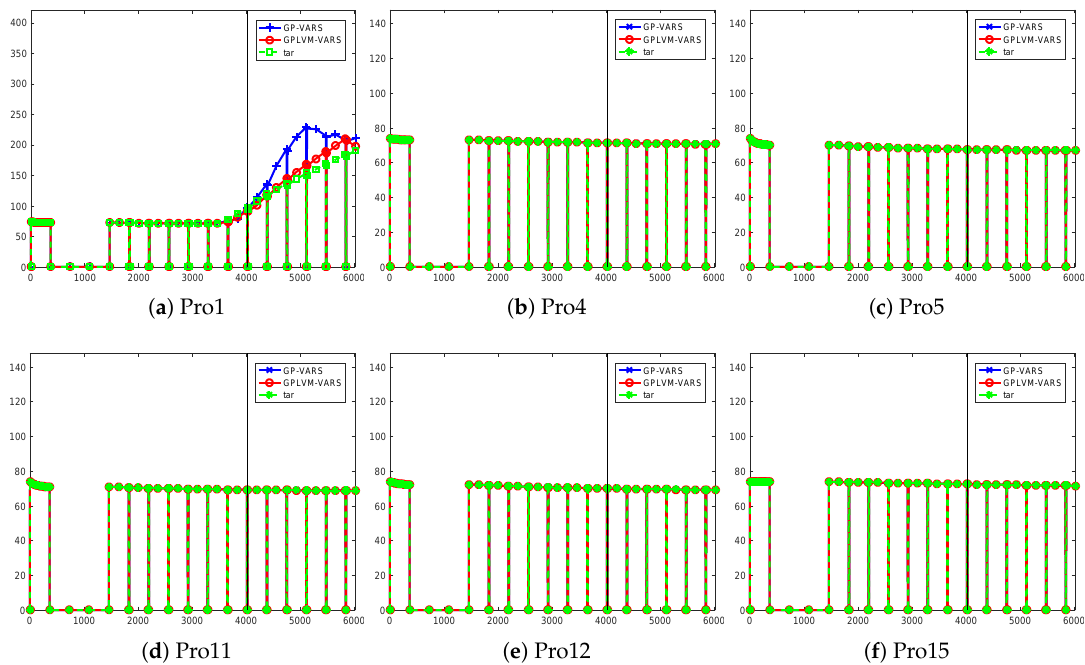
Figure 9. Comparison of WGOR with 4000 training and 2000 testing data for six wells (the black vertical line indicating present